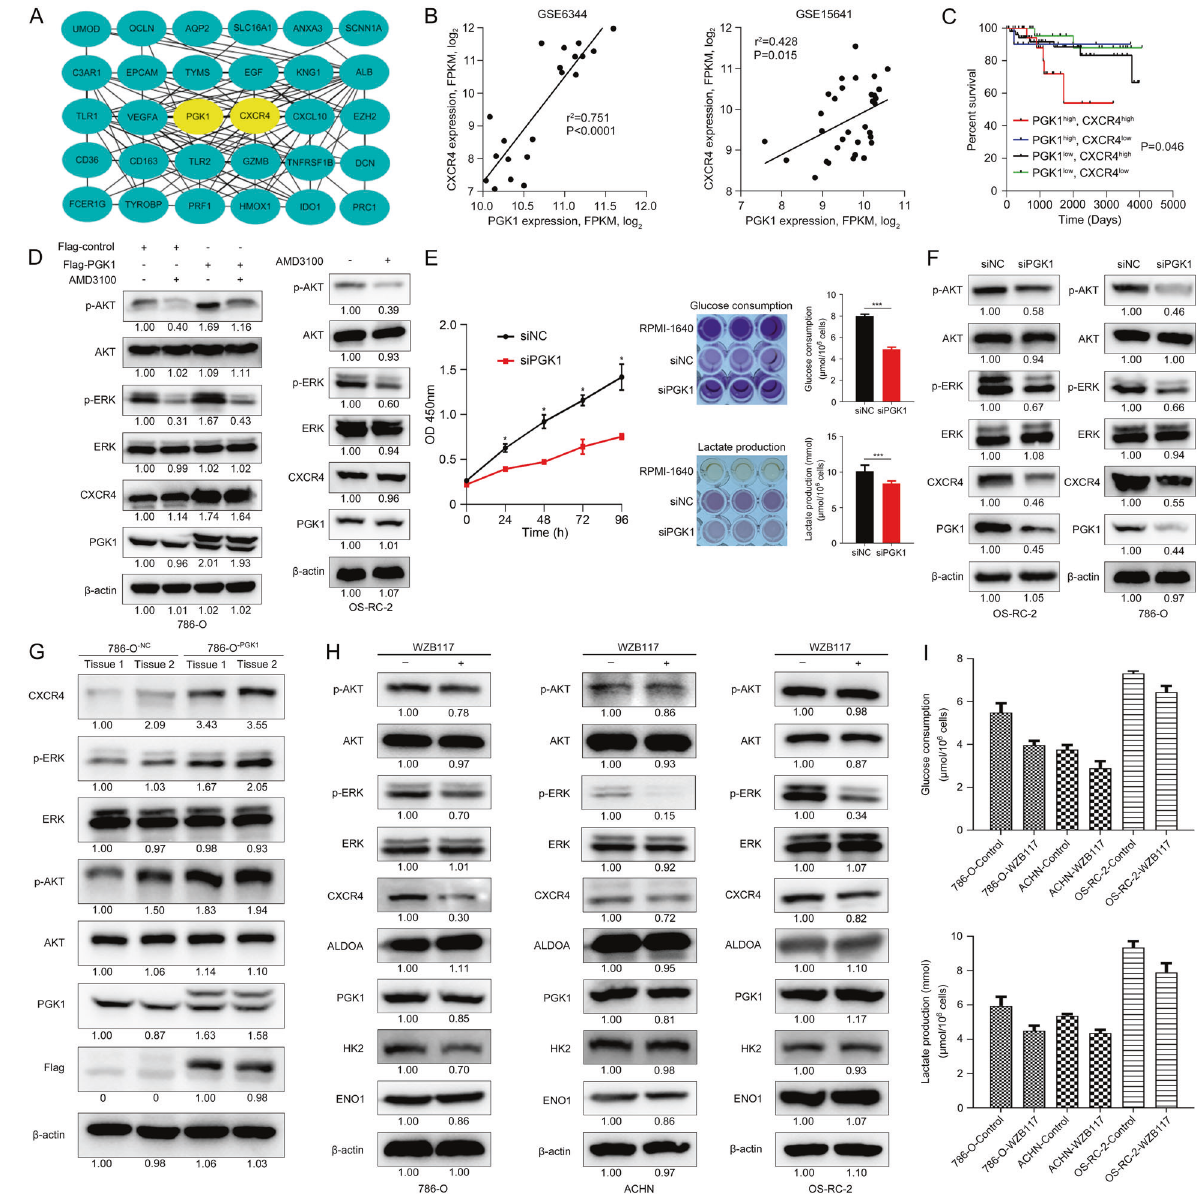
Fig. 6 PGK1 activates CXCR4/ERK pathway in KIRC cells / tissues. A PGK1 and CXCR4 were the hub genes in KIRC, and there was a strong correlation between PGK1 and CXCR4. B Co-expression of PGK1 and CXCR4 transcript levels from GSE6344 and GSE15641 dataset. C Kaplan – Meier ’ s survival analysis of the correlation between the combination of PGK1 and CXCR4 expression levels and disease-free interval (DFI) survival from TCGA KIRC objects. D PGK1 induced the CXCR4-mediated phosphorylation of AKT (p-AKT) and ERK (p-ERK), and blockade